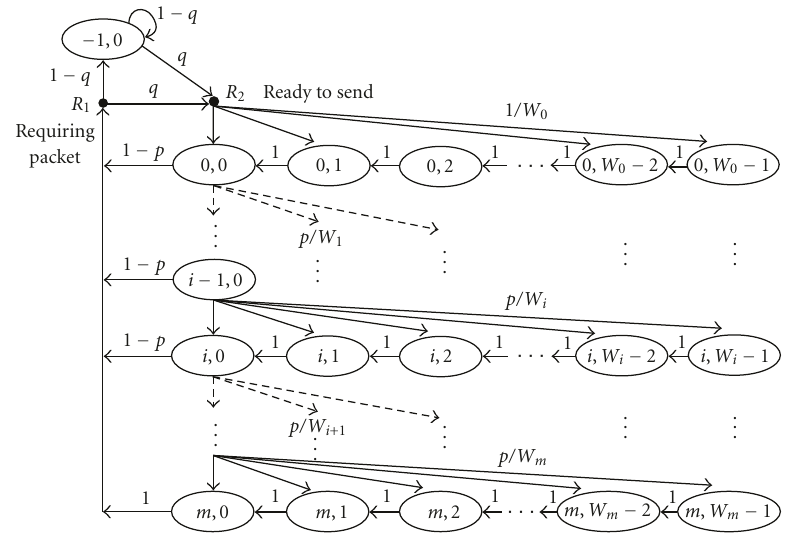
Figure 7: Improved Markov